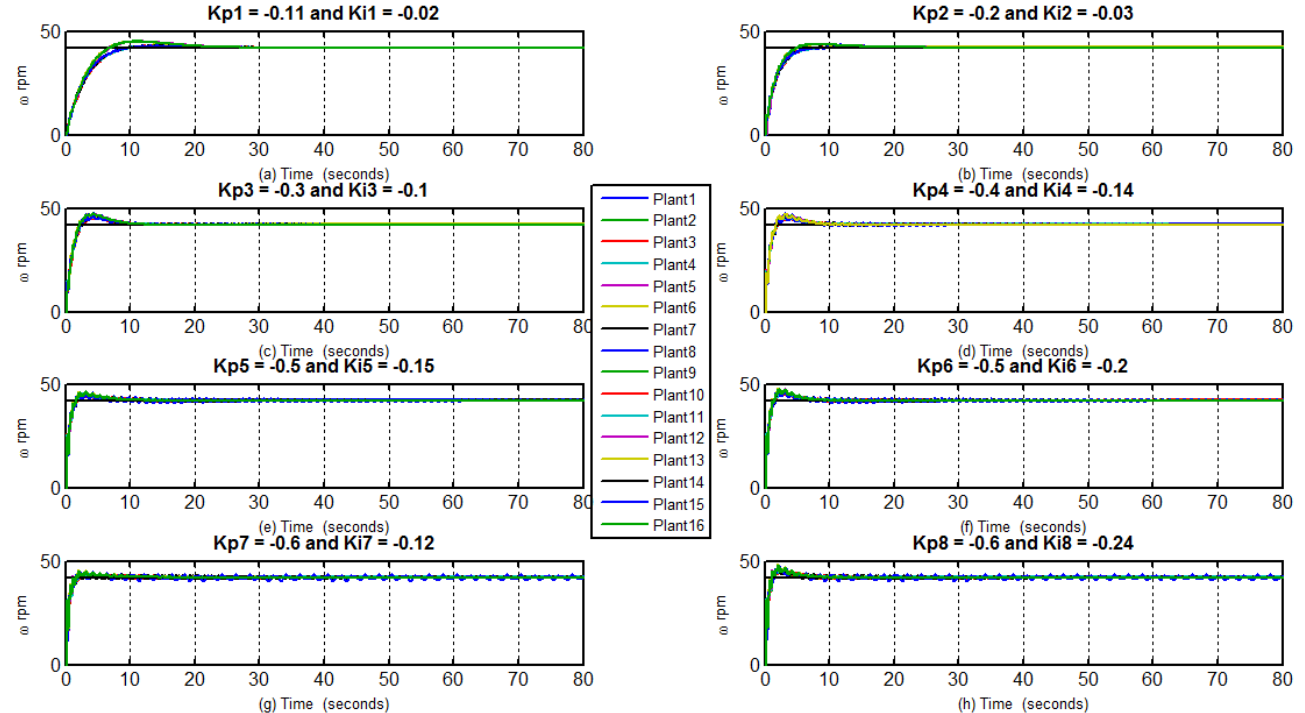
Figure 11. The step responses of 16-Kharitonov plants representing the regulation of speed to 42 rpm with minimal peak overshoot and settling times. The eight selected points are taken from the Kp and Ki stabilizing region of Figure 6